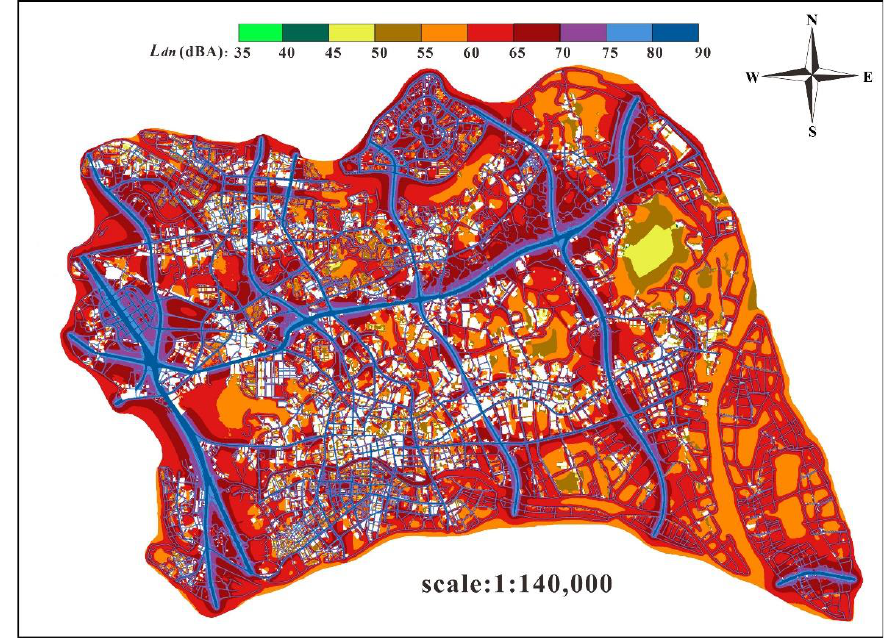
Figure A2. Nighttime urban traffic noise map of Panyu District, Guangzhou City [36].